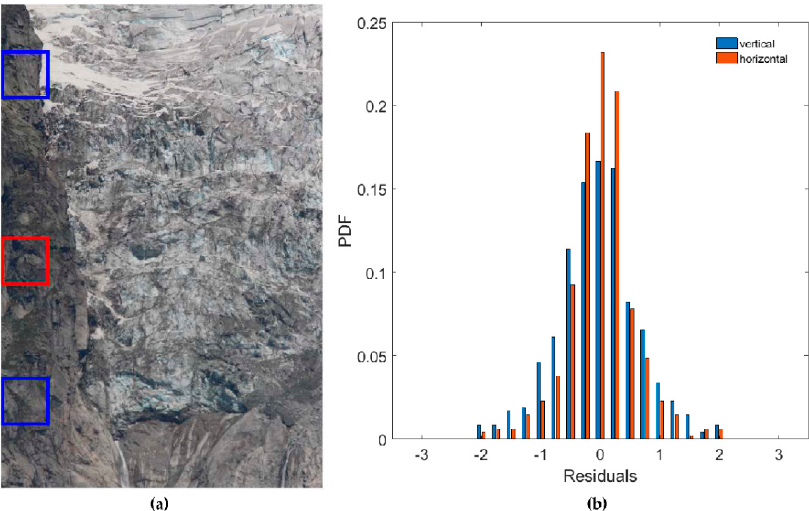
Figure 5. ( a ) In red the reference window used for the co-registration process, lying on the rock outcrop. In blue the two windows used for error estimation; ( b ) Frequency distributions of Mean Absolute Error computed separately for the vertical (blue) and horizontal (orange) dimensions.